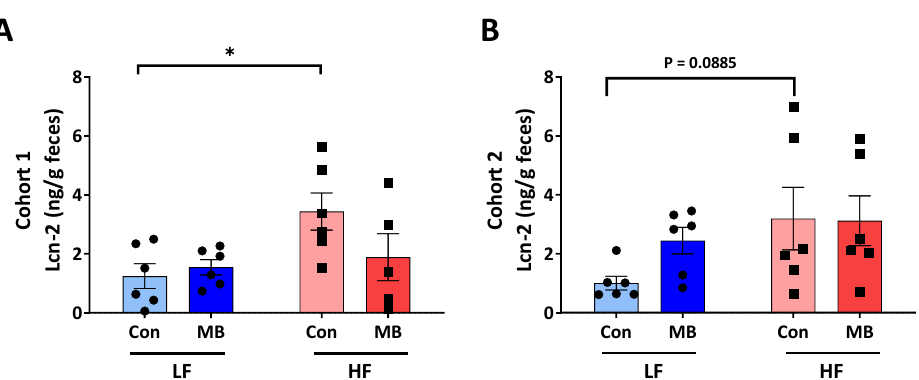
Figure 2. Effect of MB supplementation on fecal lipocalin (Lcn)-2 in cohort 1 ( A ) and cohort 2 ( B ) of mice fed an LF or HF diet with or without 0.25% MB supplementation diet for 6 weeks. Two-way analysis of variance followed by Sidak’s post hoc test was used to determine differences among groups. Values are means ± SEMs; n = 6/group/cohort. Asterisk (*) denotes significant differences among groups at * p < 0.05. HF, high-fat; HF/CON, HF without MB; HF/MB, HF with 0.25% MB ( w / v ) in drinking water; LF, low-fat; LF/CON, LF without MB; LF/MB, LF with 0.25% MB ( w / v ) in drinking water; MB, monobutyrin.